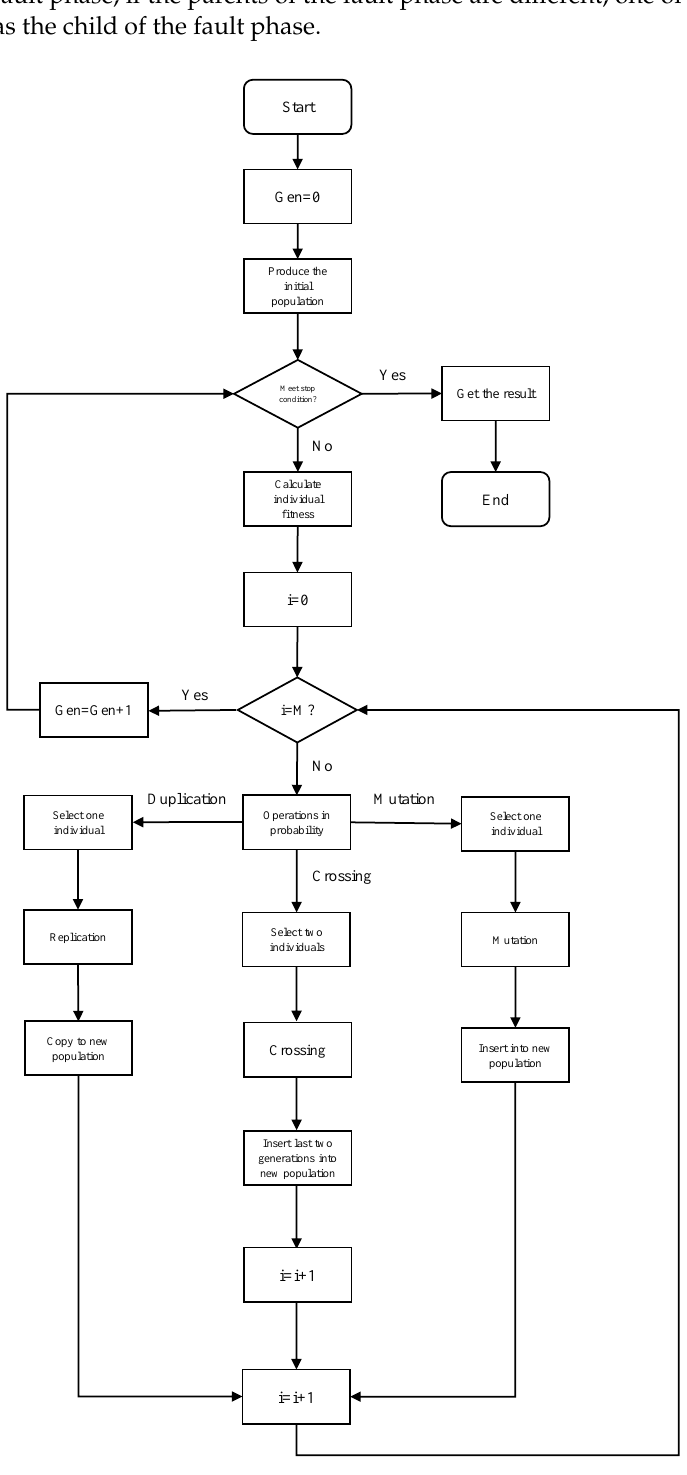
Figure 4. The flow chart of